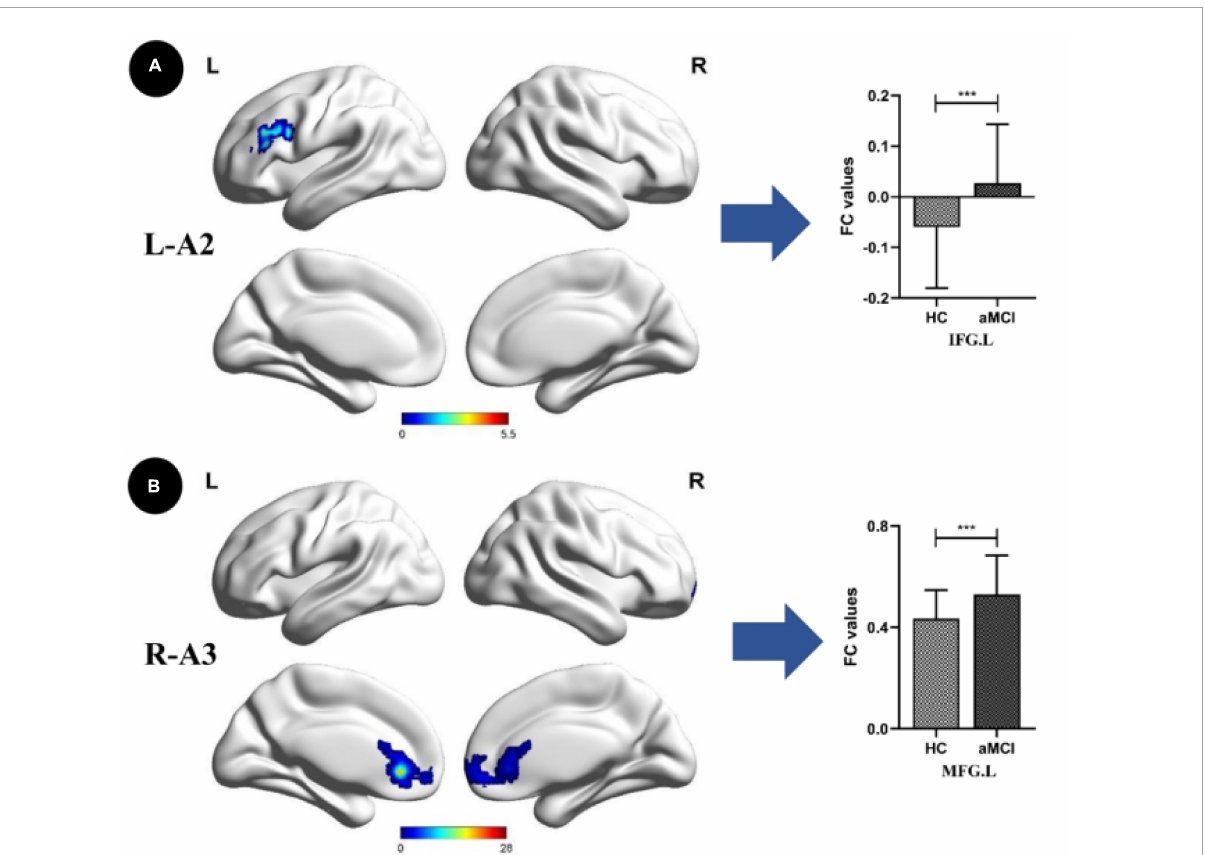
FIGURE3 Anterior cingulate cortex subregions functional connectivity in patients with amnestic mild cognitive impairment (aMCI) compared to healthy control (HC). (A) Functional connectivity (FC) of left dorsal anterior cingulate cortex subregion (L-A2) between HC and aMCI patients. A bar chart indicating the quantitative comparison of FC between these regions. (B) FC of right subgenual anterior cingulate cortex subregion (R-A3) between HC and aMCI patients. A bar chart indicating the quantitative comparison of FC between these regions. Only the subnetworks that show between-group differences are shown here. All results are displayed alter adjusting for age, sex and education. A threshold of p < 0.05 was applied, with a TFCE-FWE correction with cluster size > 200 mm 3 . FC, functional connectivity; HC, healthy controls; aMCI, amnestic mild cognitive impairment; IFG.L, left inferior frontal gyrus; MFG.L, left middle frontal gyrus. *** p <